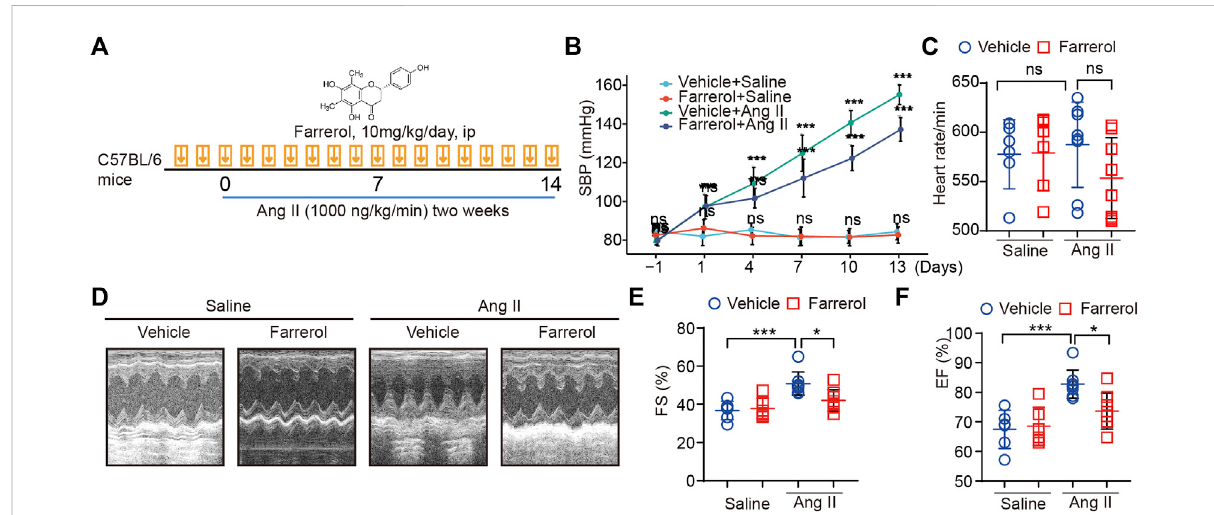
FIGURE 1 Farrerol inhibits Ang II-induced hypertension and cardiac dysfunction in mice. (A) Graphical fl ow chart; (B) Systolic blood pressure of mice in different treatment groups; (C) Heart rate of mice in different treatment groups; (D – F) Representative M-mode echocardiography of left ventricular (LV) chamber and echocardiographic assessment of FS(%), EF (%) (Salline = 6, Farrerol = 6, Ang II = 8, Ang II + Farrerol =